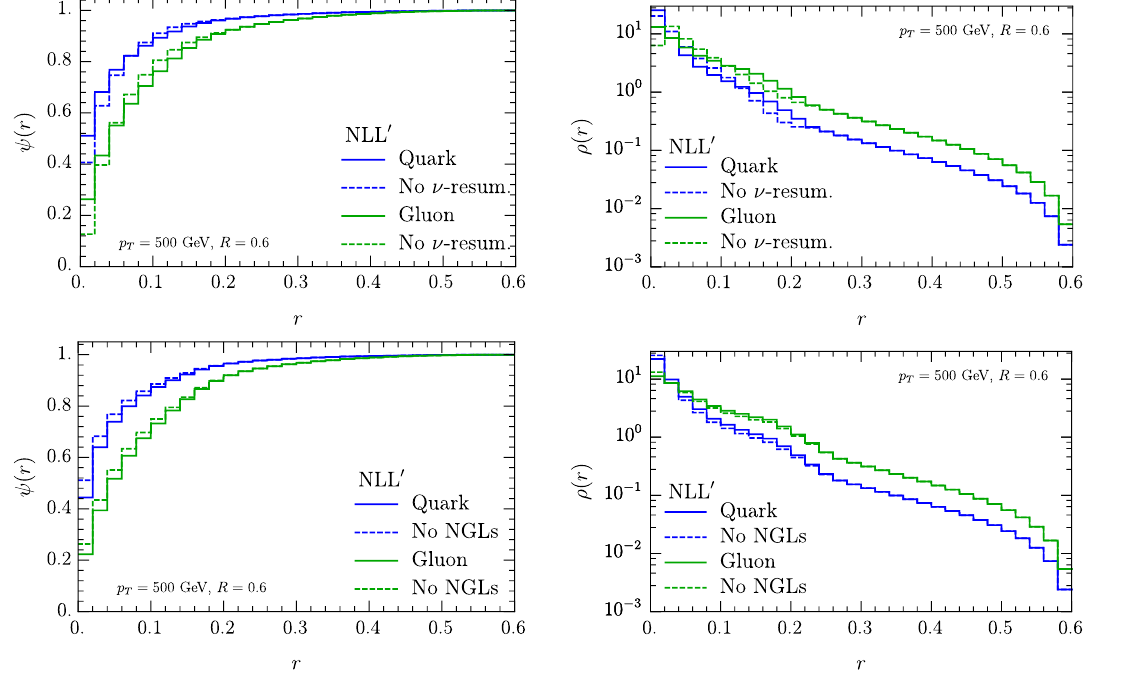
Figure 9 . The integrated (left) and di(cid:11)erential (right) jet shape for quark jets (blue) and gluon jets (green) at NLL 0 with p T = 500 GeV and R = 0 : 6. The top row shows the result with (solid) and without (dashed) rapidity resummation. The bottom row shows the result with (solid) and without (dashed) non-global